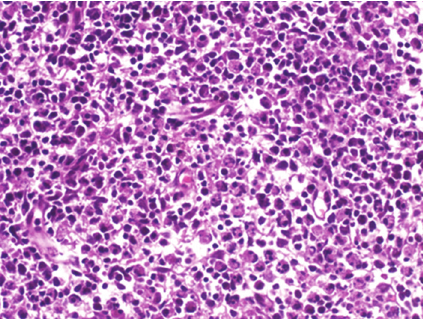
Figure 2: Necrotic area devoid of polymorphonuclear leukocytes but contains karyorrhectic debris (H&E, × 40).